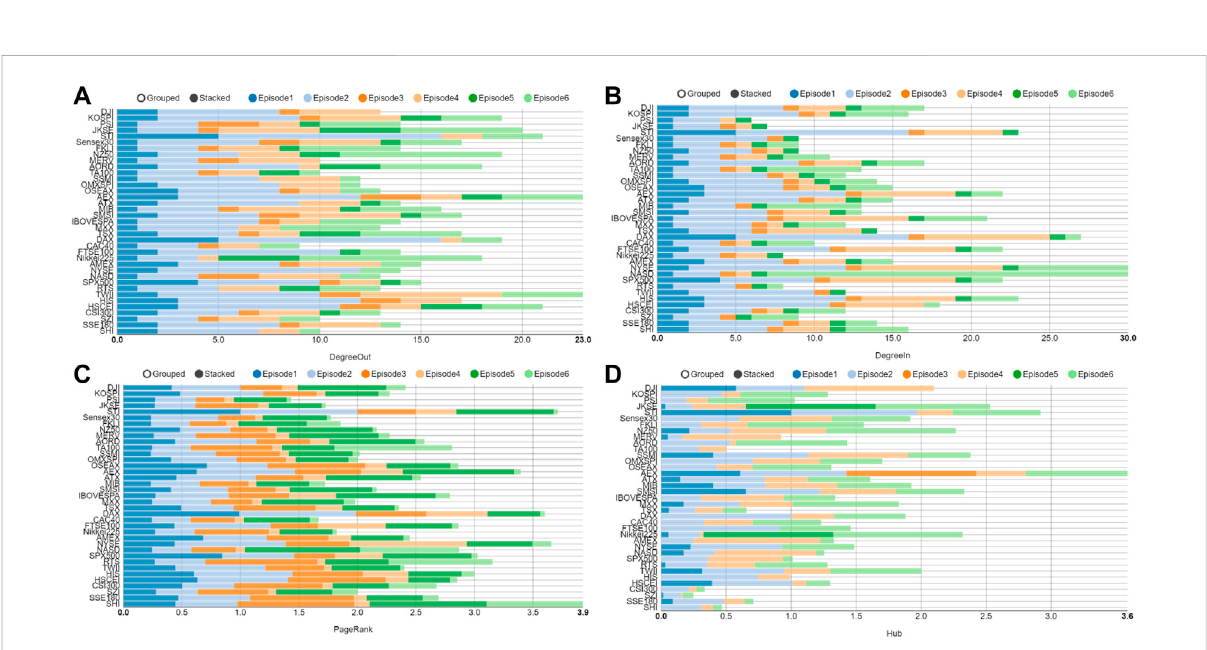
FIGURE 5 (Coloronline)Parametersofeachlayernetworkatthetimeofglobal fi nancialcrisis. (A) Theout-degreeofeachlayernetwork; (B) Thein-degree of each layer network; (C) The PageRank of each layer network; (D) The Hub of each layer